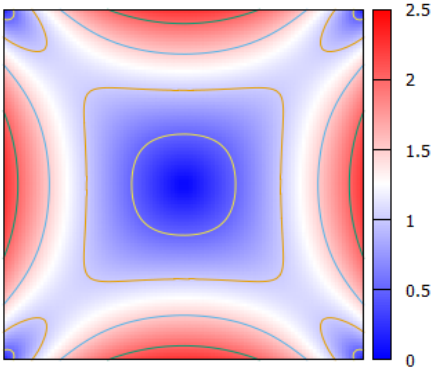
(cid:17) (cid:16) (cid:12) (cid:12) . U max (cid:3022) (cid:3288)(cid:3276)(cid:3299) γ , for the flow of a Newtonian fluid in a (cid:12) (cid:12) / ) , for the flow of a Newtonian fluid in a H /2 (cid:3009)/(cid:2870)